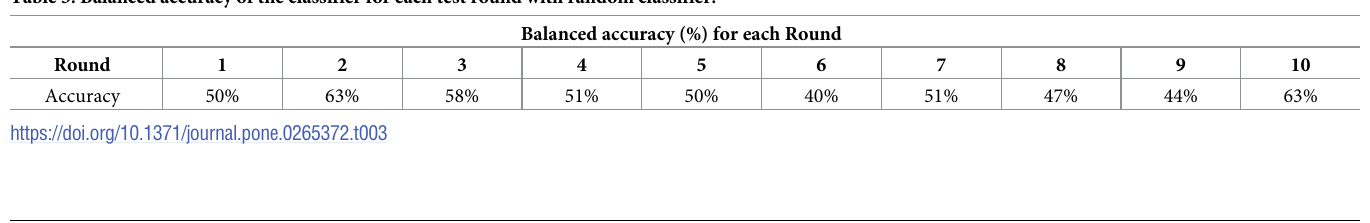
Table 3. Balanced accuracy of the classifier for each test round with random